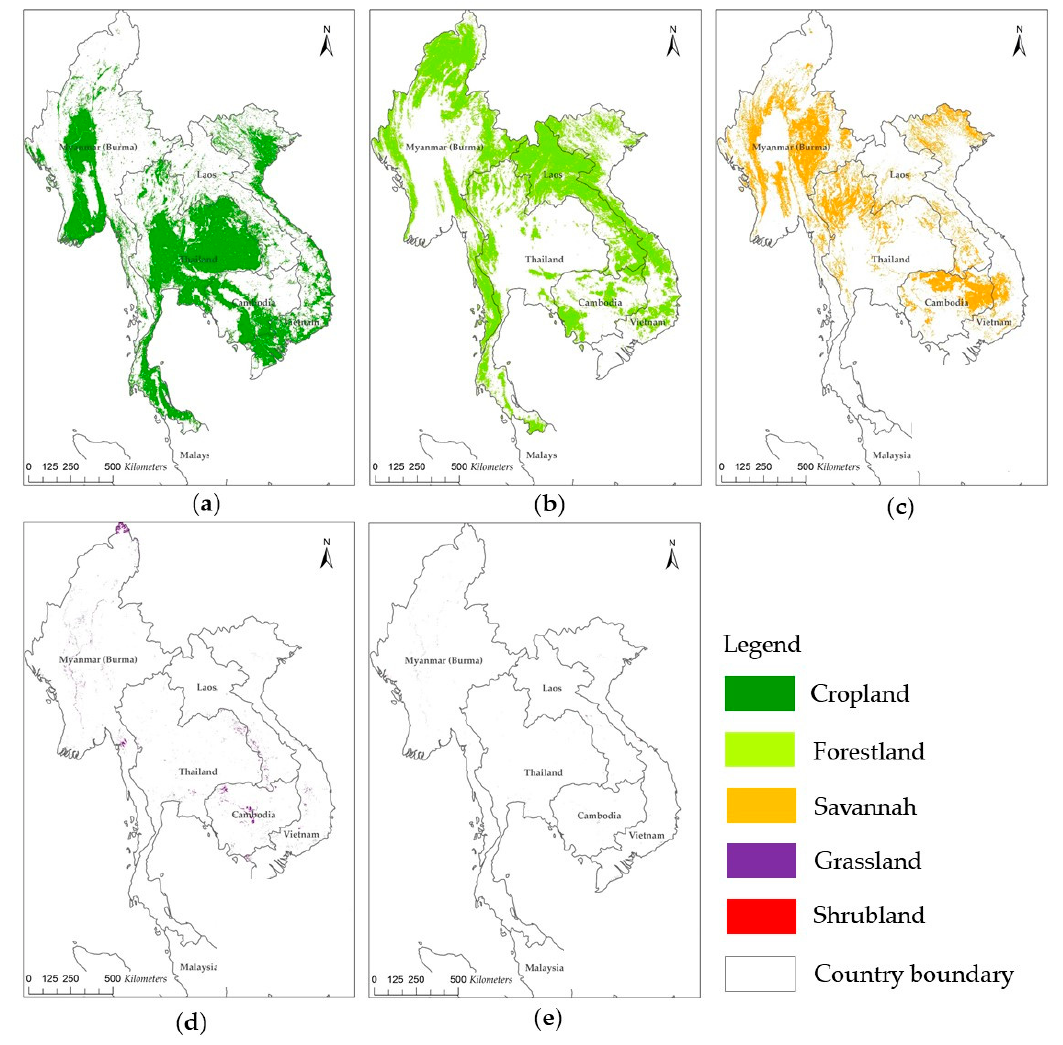
Figure 3. Land use map of ( a ) cropland, ( b ) forestland, ( c ) savannah, ( d ) grassland, and ( e ) shrubland in the GMS for the year 2015 derived from the MCD12Q1.